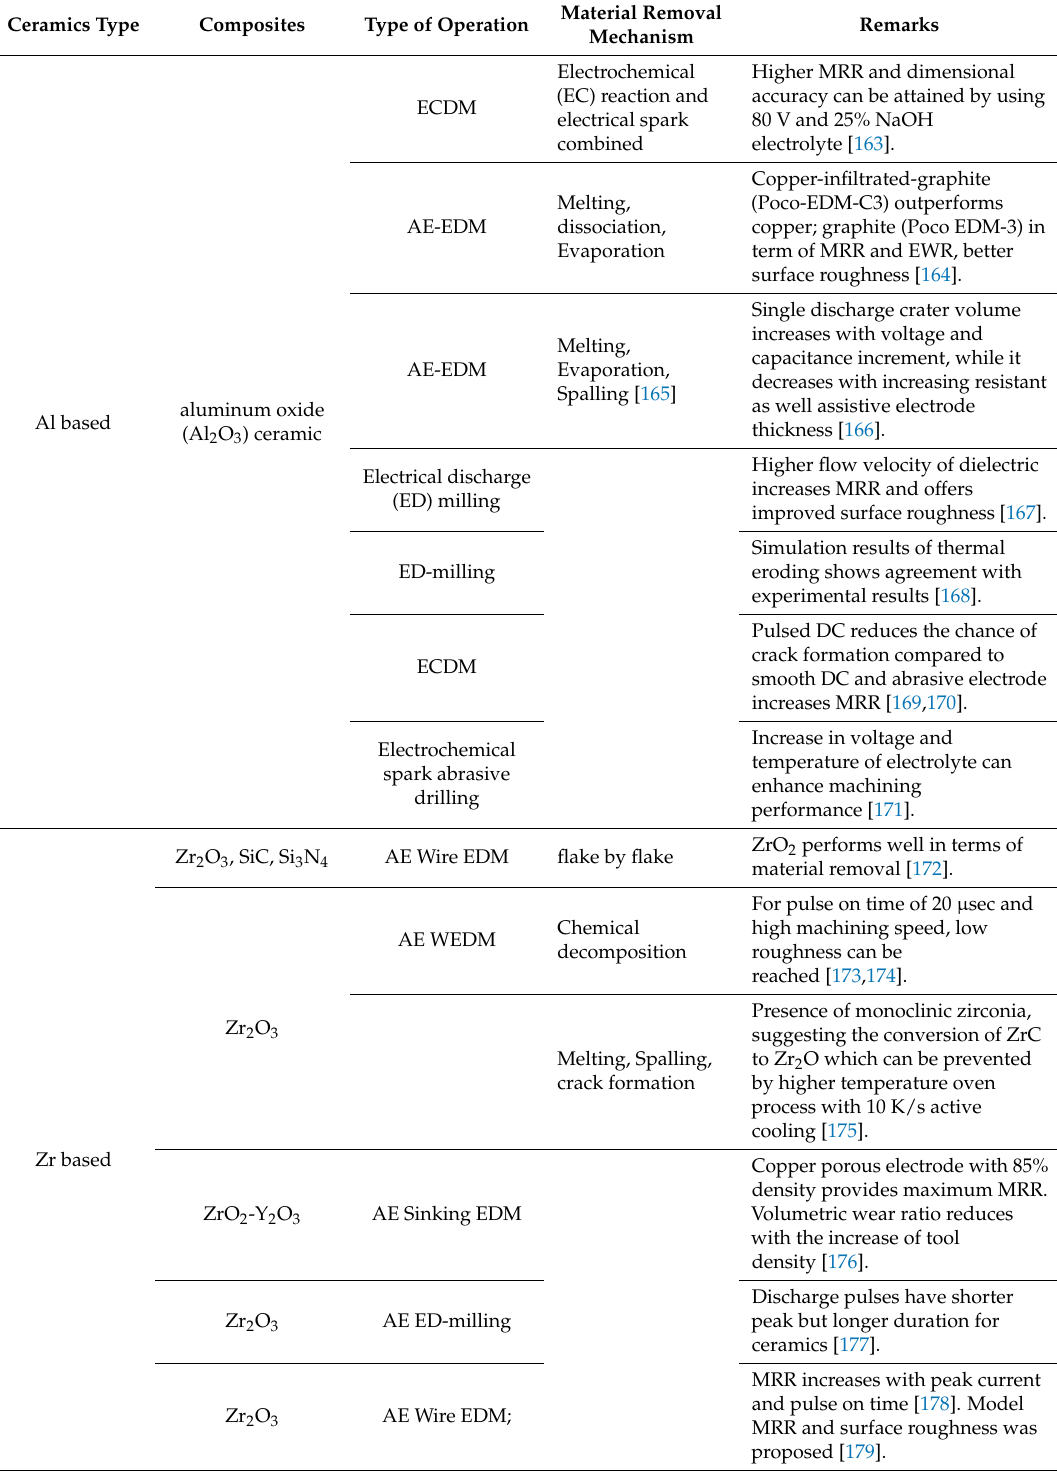
Table 4. Summary of EDM of Non-conductive